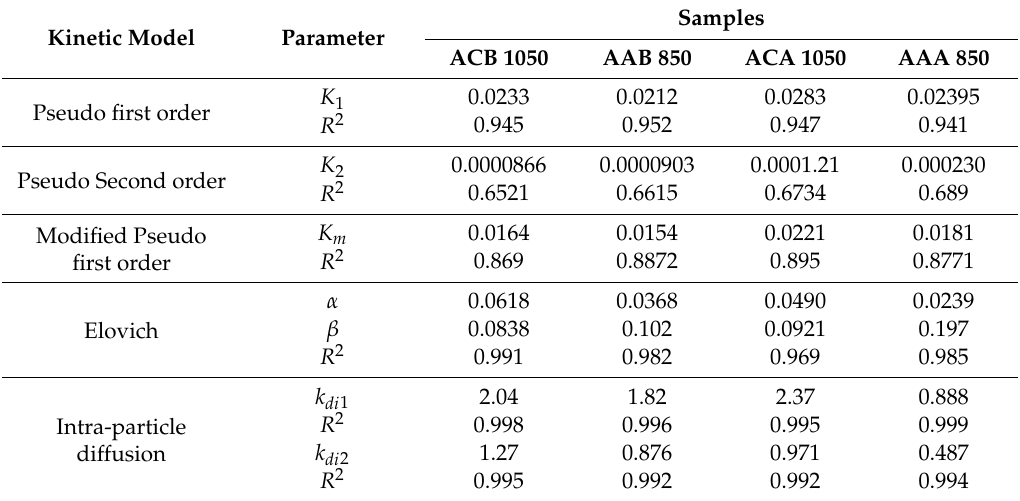
Table 3. Obtained parameters for the kinetics of adsorption of CO 2 on the surface of aerogels. Kinetic Model